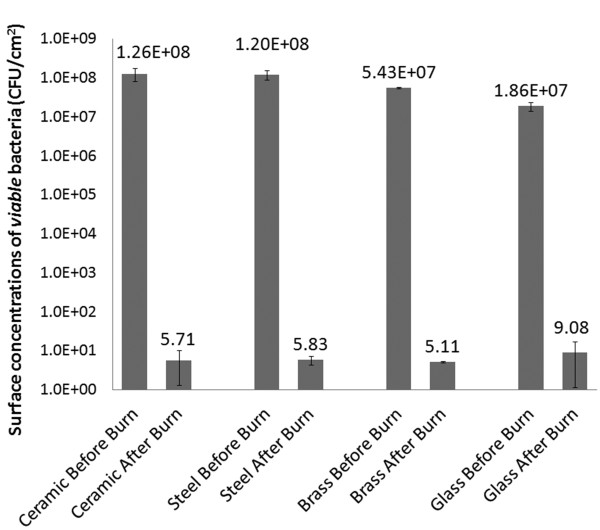
Efficacy of our ultra-rapid process for the removal of biofilms: The graph shows the average (n = 4) and standard deviations for the surface concentration of viable bacteria (CFU/cm2) on different materials before and after the combustion process.